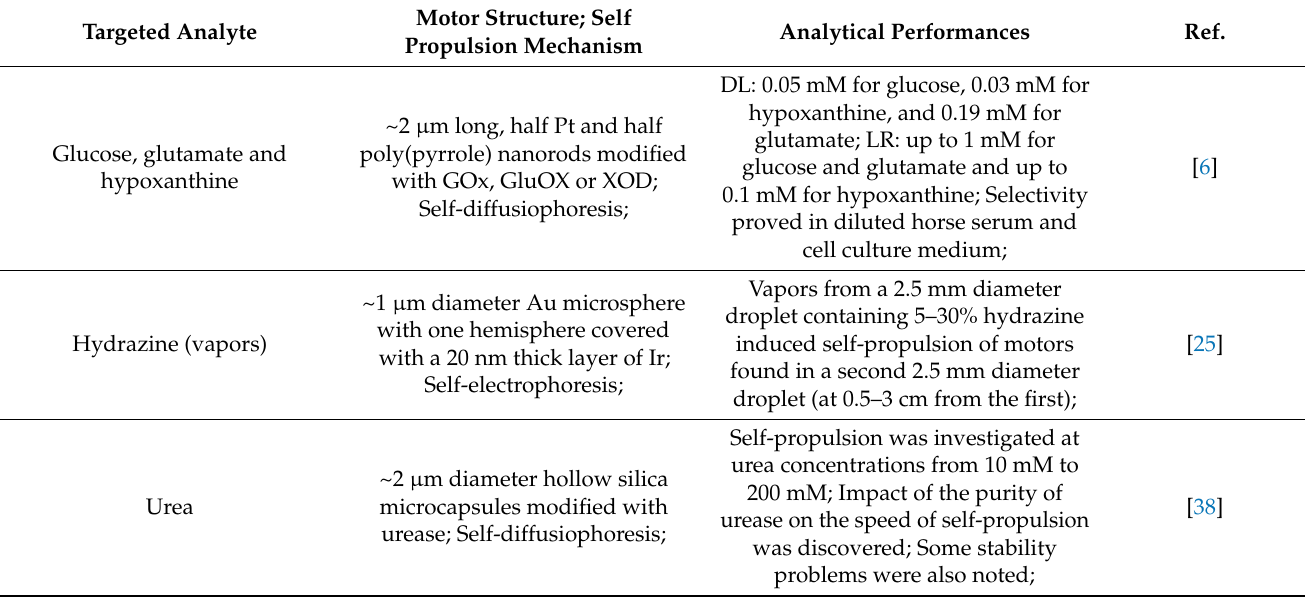
Table 1. Examples of catalytic micromotors which were used to detect/quantify their fuel. (Used abbreviations: GOx = glucose oxidase, GluOx = glutamate oxidase, XOD = xanthine oxidase, DL = detection limit, and LR = linear